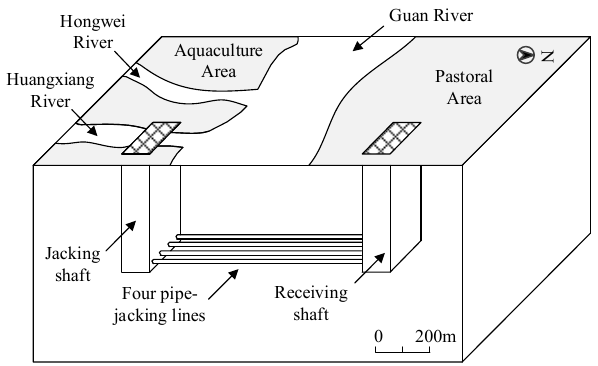
Figure 6. Location of pipe-jacking construction site.